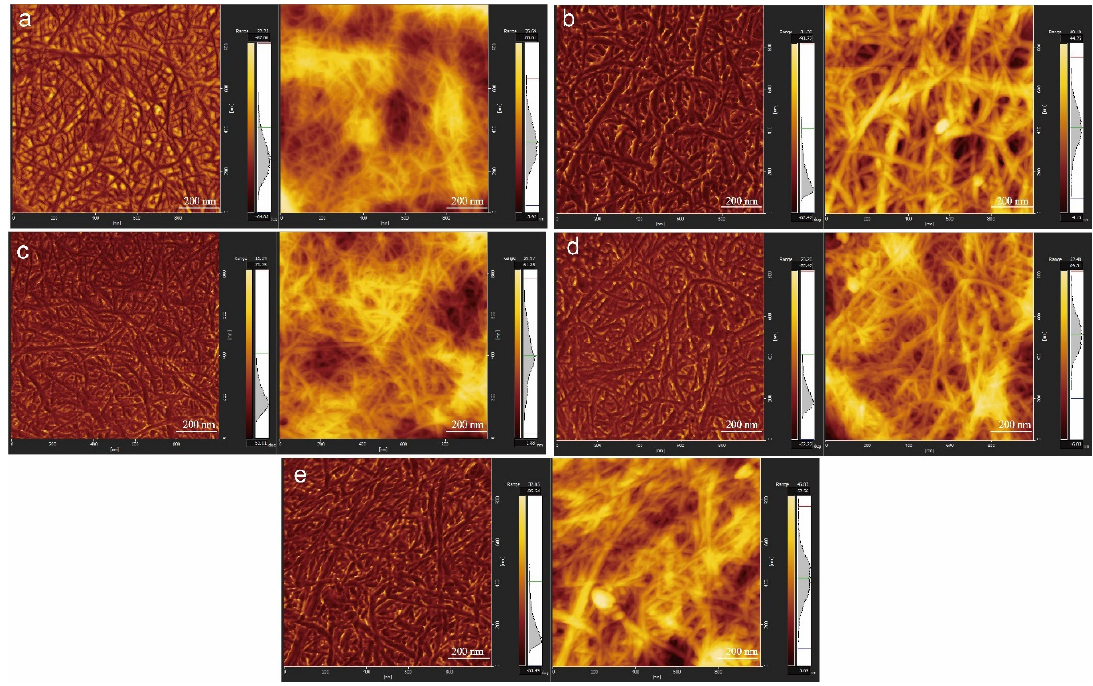
Figure 2. Atomic force microscopy (AFM) images of unmodified and modified CNF samples: ( a ) CNF; ( b ) J-CNF; ( c ) Z-CNF; ( d ) J-Z-CNF; and ( e ) Z-J-CNF.